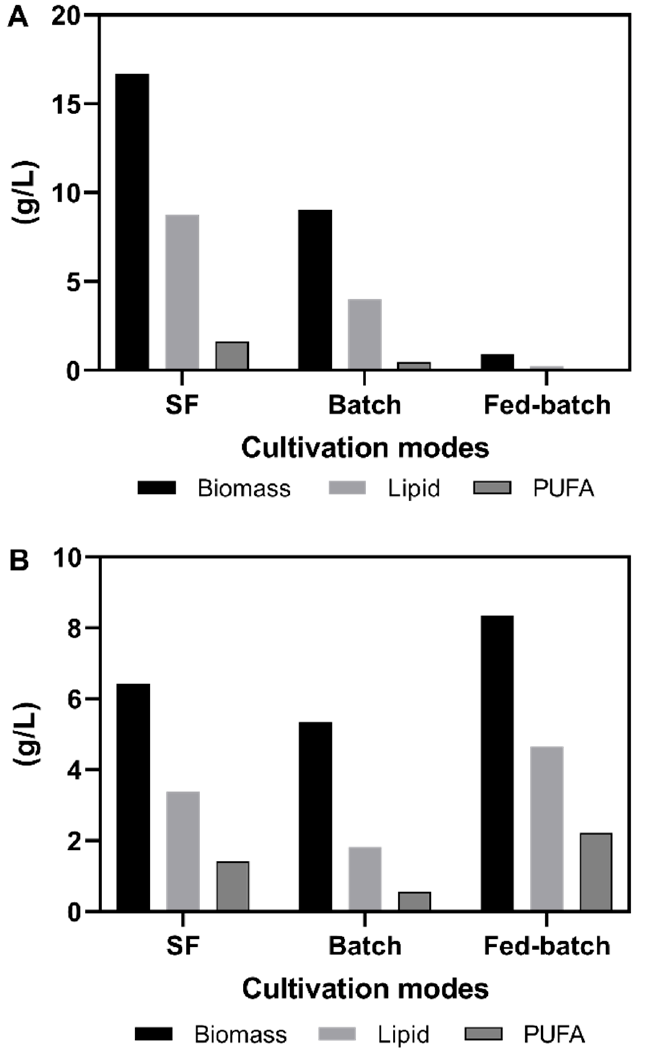
Figure 9. The biomass, total lipid content, and unsaturated fatty acids (GLA+ARA) concentrations obtained at the end of Shake flask (SF) experiment, batch and fed-batch fermentation for M. circinelloides ( A ) and M. alpina ( B ).